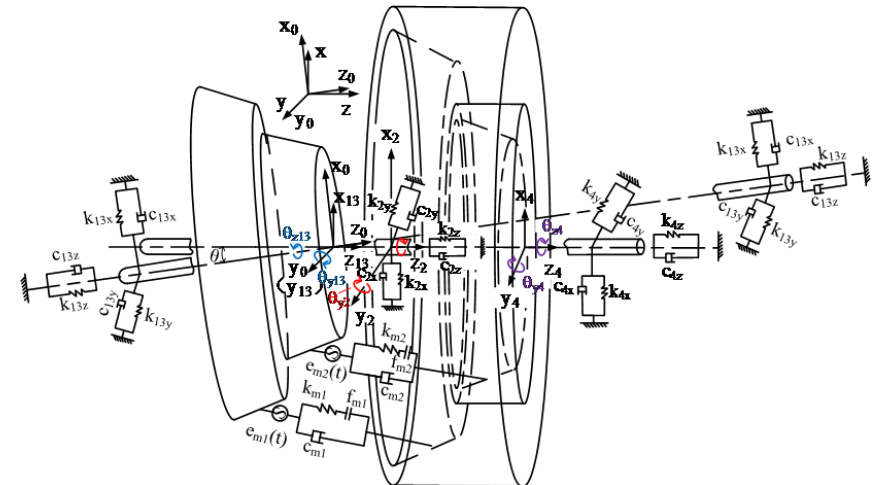
Figure 3. Dynamic analysis model of the two-stage nutation drive system.